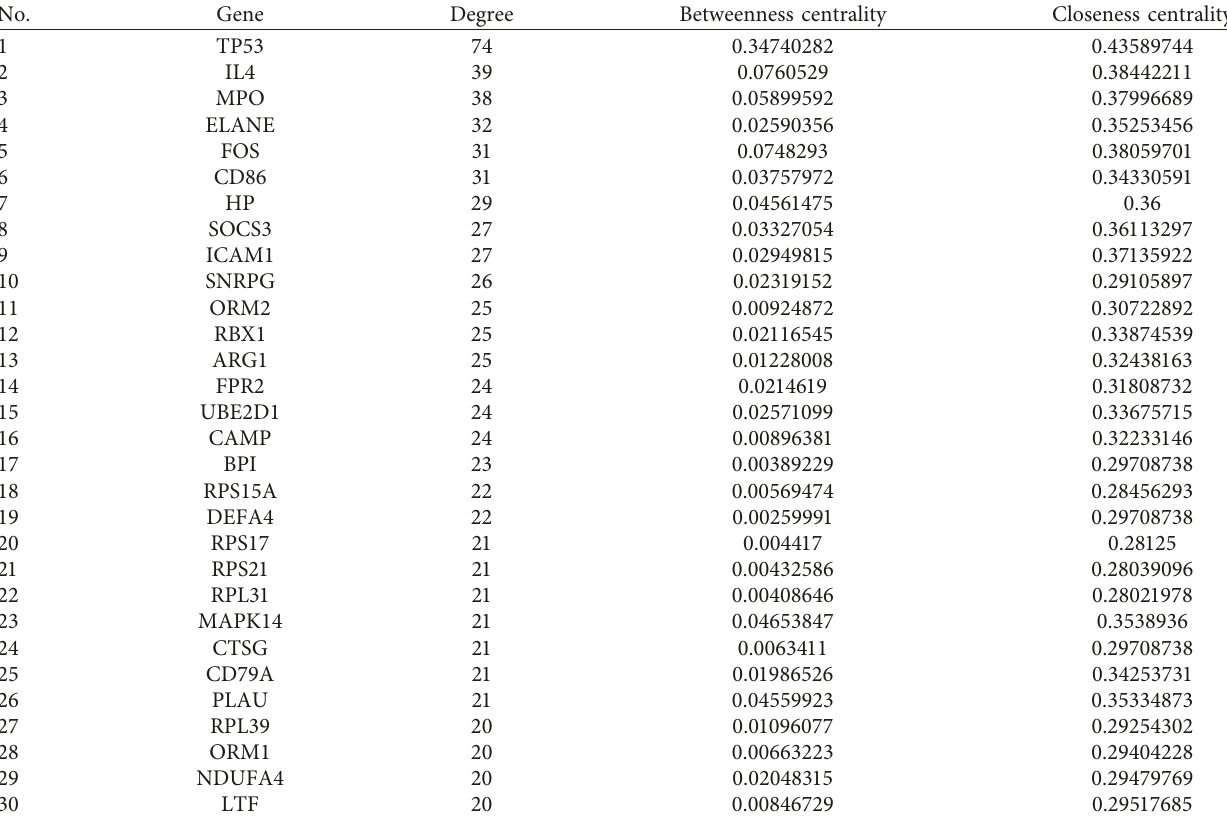
Table 3: The top 30 hub proteins identified in the topological analysis of the PPI network of DEGs2.